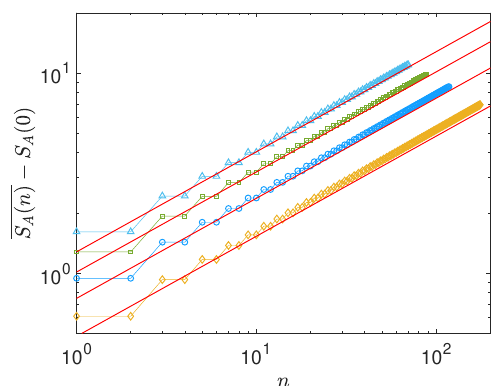
Figure 10: Growth of the averaged entanglement entropy at the type I exceptional points. The dotted data are exact results in (48) with φ = 0 and c = 1, and the red solid lines correspond to the approximated analytical results in (51). From top to bottom, the parameters are ϕ = 10, 8, 6, and 4,